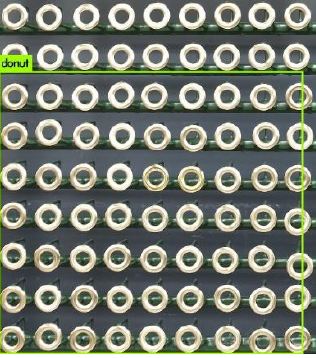
Figure 3. Prediction result obtained with an off-the-shelf pre-trained YOLO (you only look once) net.